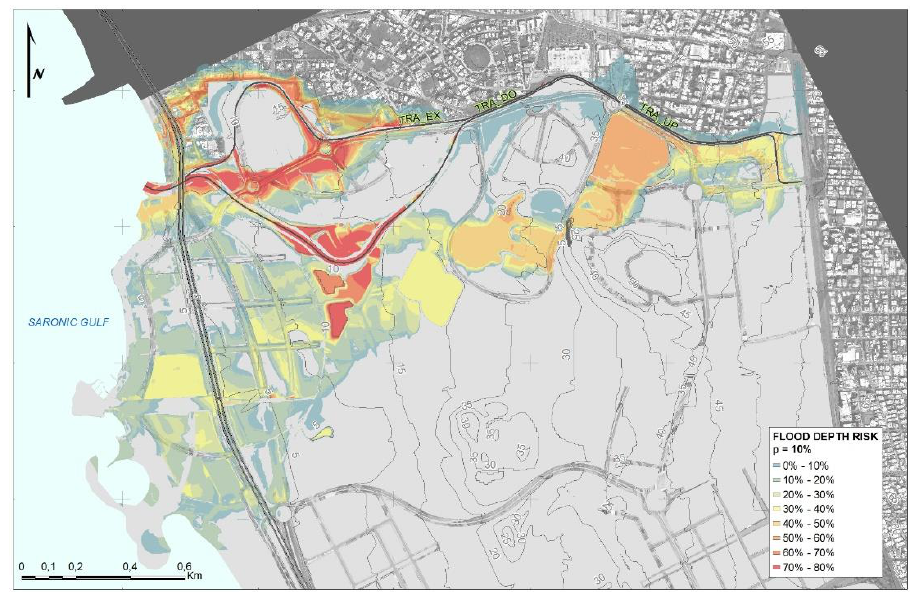
Figure 12. Mapping of flood depth hazard (10% confidence limit).